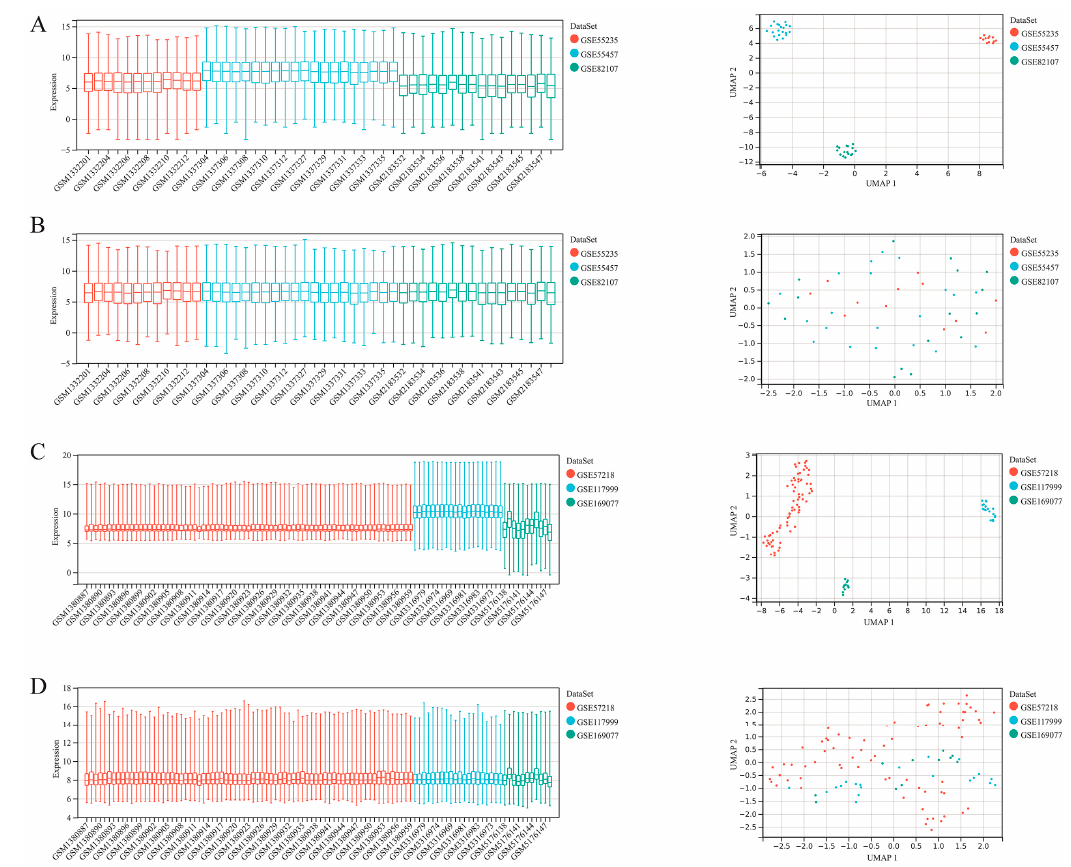
Figure 1. Dataset integration. The results are shown in box plots and density graphics. GSE55235, GSE55457, GSE82107: before merge ( A ), after merge ( B ), GSE57128, GSE117999, GES169077: before merge ( C ), after merge ( D ).